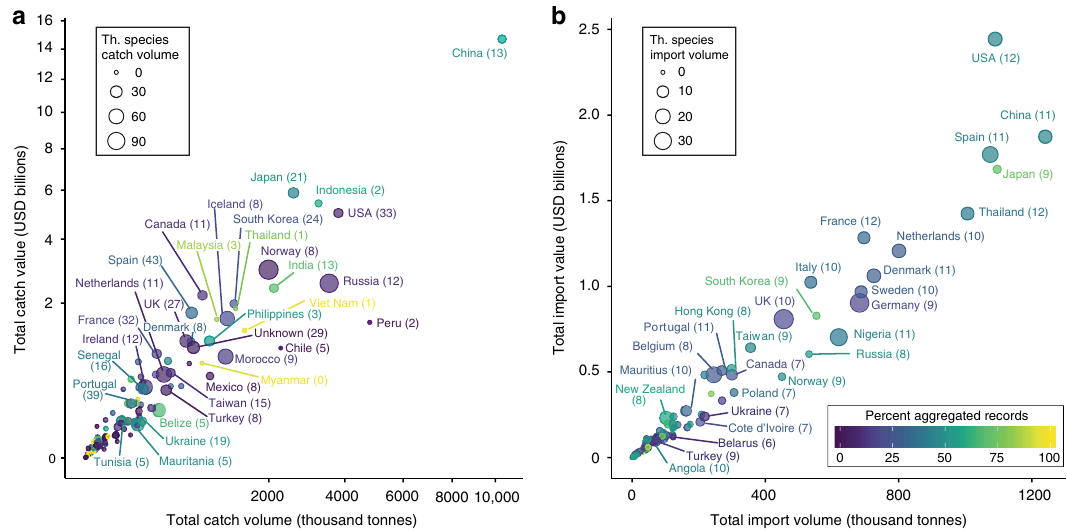
Fig. 3 Threatened species catch and import volumes and values compared to country totals. Catch volume and estimated value for 163 fi shing countries are shown on a log transformed scale ( a ) and import volume and estimated value for 204 importing countries are shown on a continuous scale ( b ). Bubble size corresponds to volume of threatened species catch or imports (thousand tonnes). Number of threatened species each country catches or imports is in parentheses. Colour shows the percent of each country ’ s catch or import volume that is aggregated (i.e. yellow indicates catch and import volumes mostly recorded in aggregated groups and purple indicates catch and import volumes mostly recorded to the species level). Volumes and values are weighted moving averages for 2014 for catch and 2015 for